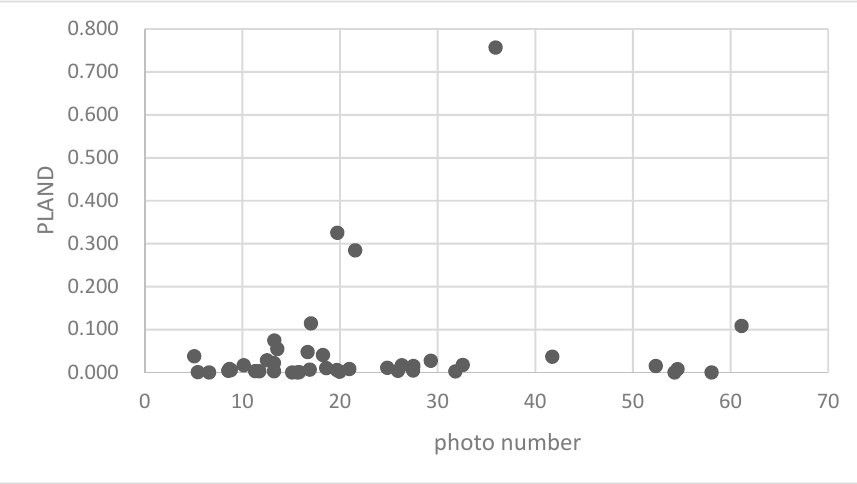
Figure 23. Association between the forest land PLAND index and potassium retention capacity.